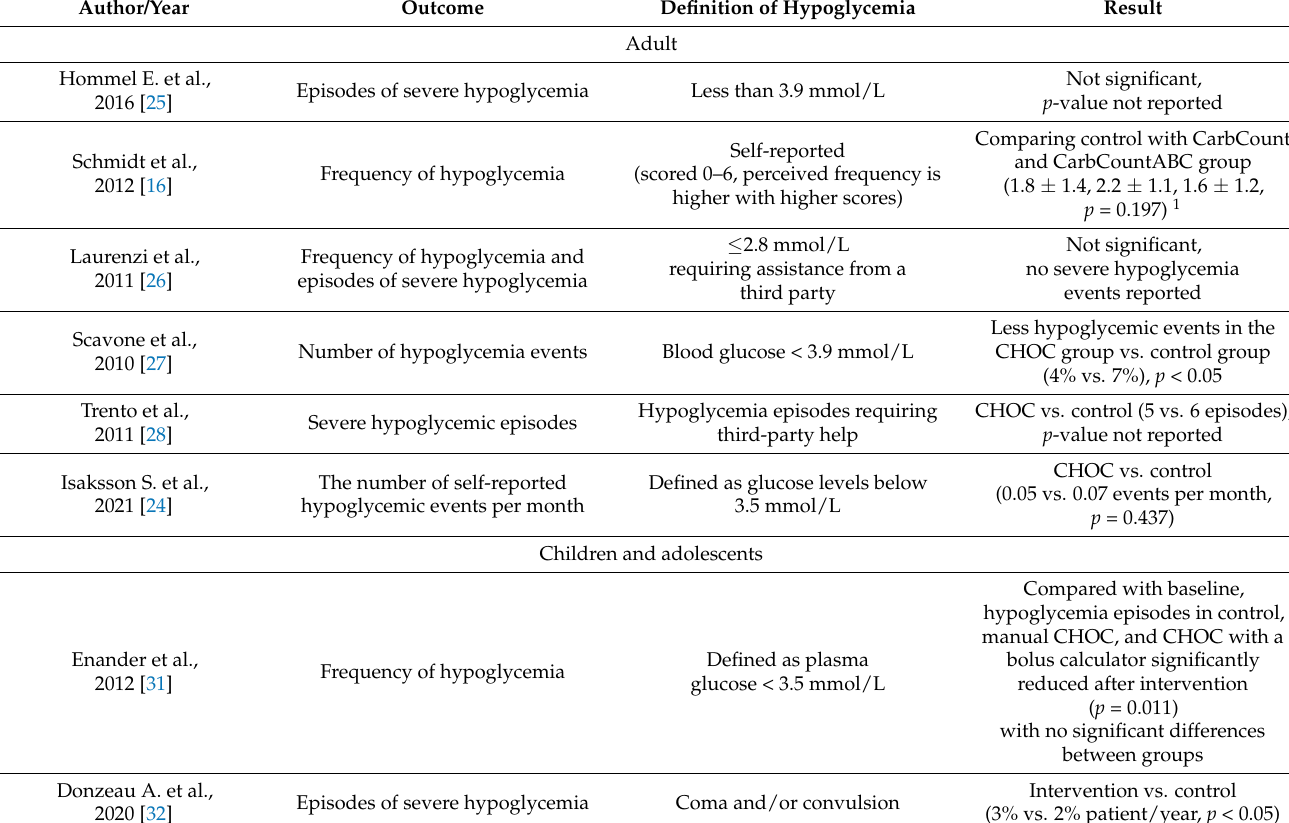
Table 2. Frequency of severe